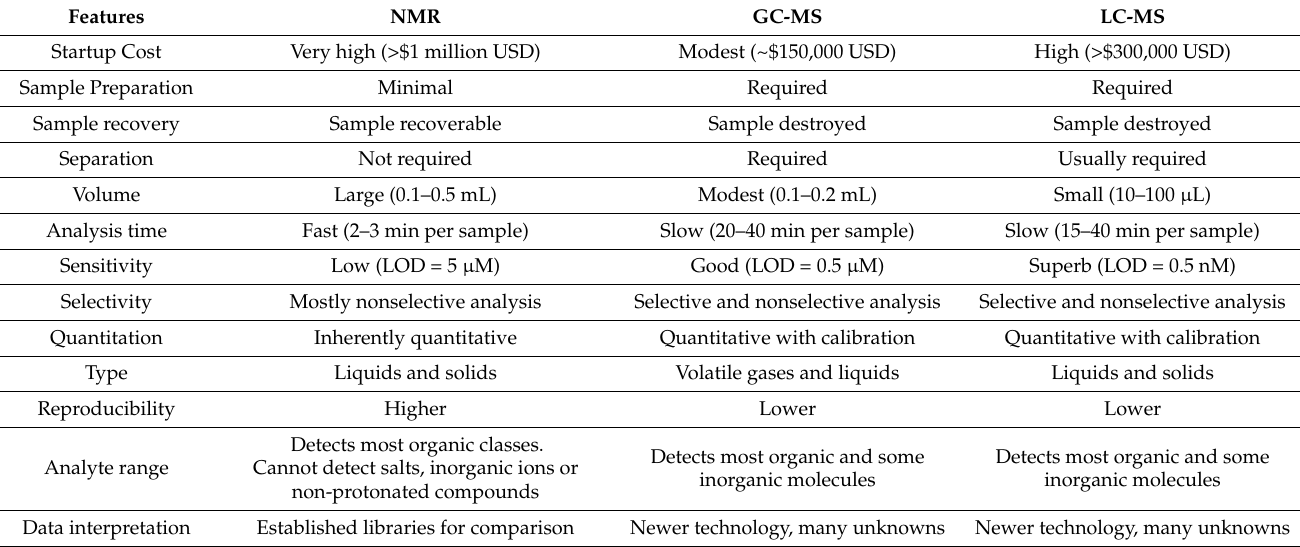
Table 1. Comparison of commonly employed analytical platforms used in